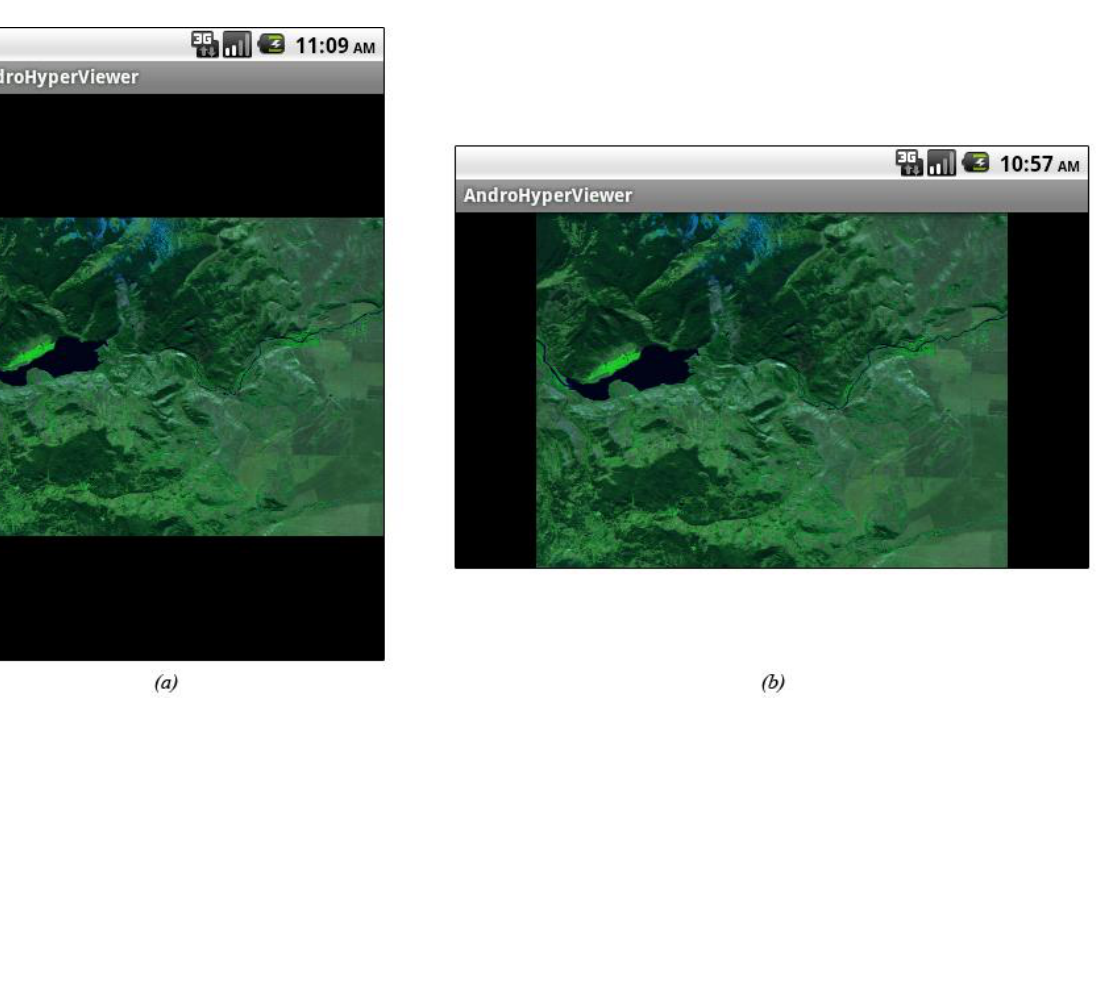
Figure 5. Yellowstone Calibrated Scene 01 on Google Android SDK Emulator in portrait mode and landscape mode with a HVGA screen